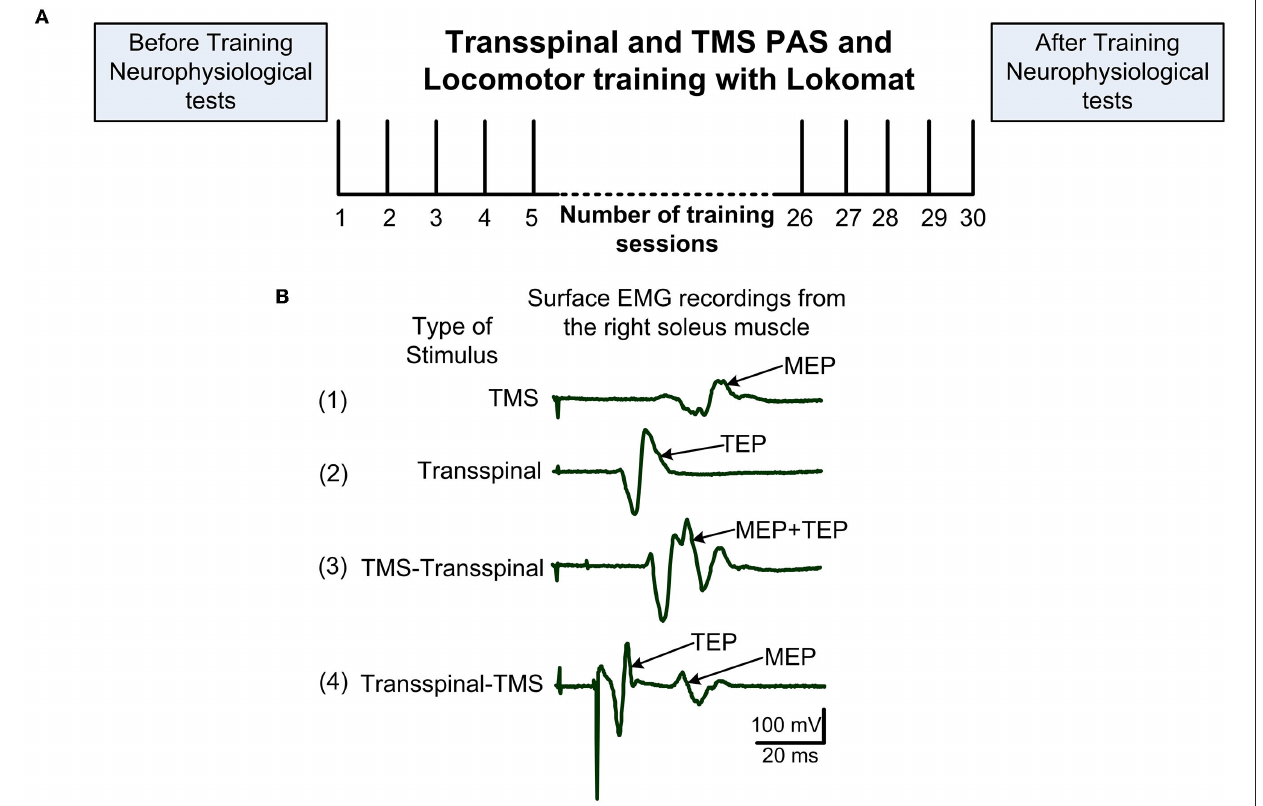
FIGURE 1 | Experimental procedures. (A) After eligibility to the study was established, each subject was randomized to receive transspinal and transcranial magnetic stimulation (TMS) coupled with locomotor training via the Lokomat 6 Pro®. Before and 1-day after training neurophysiological tests were performed. Training sessions were delivered 5 days/week and 30 sessions were targeted but the number of sessions was adjusted based on unpredicted factors like snow. (B) Example of 20 non-rectified waveform averages recorded from a single participant while at rest of soleus MEP following TMS alone (1) , soleus TEP following transspinal stimulation alone (2) , soleus EMG following TMS delivered before transspinal stimulation (3) , and soleus EMG following TMS delivered after transspinal stimulation (4) . In protocol 3, summation of MEP and TEP compound action potentials resulting in MEP facilitation is evident. In protocol 4, TEP and MEP do not interact and are easily separated in the surface EMG. EMG, electromyogram; MEP, motor evoked potential; TEP, transspinal evoked